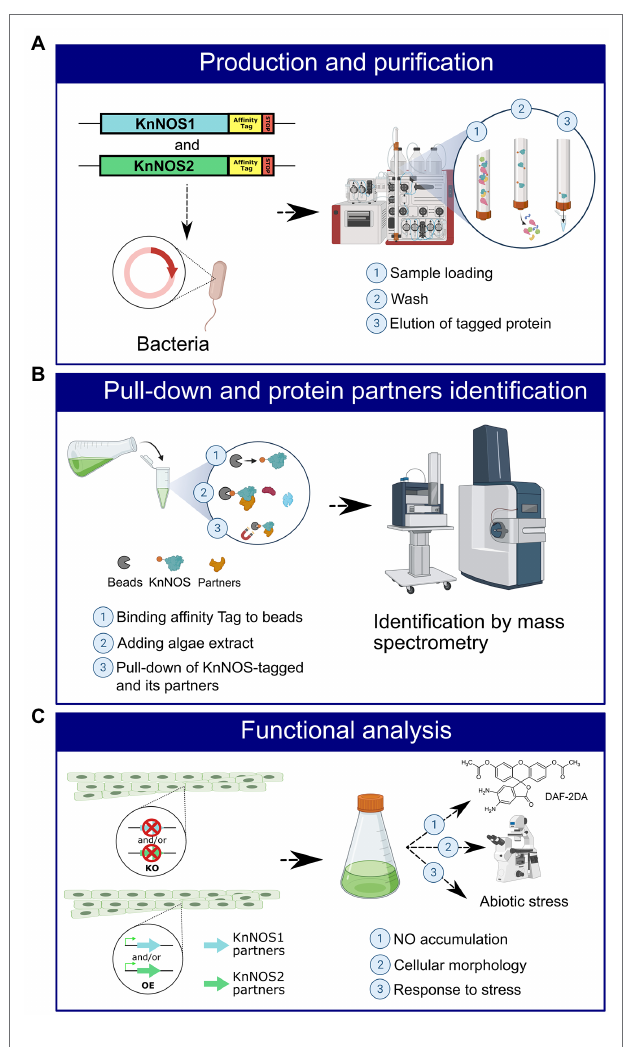
FIGURE 5 | Schematic representation of the strategy for identifying NOSs protein partners and their characterization. (A) An affinity tag will be added by molecular engineering to the sequence coding for KnNOS1 and KnNOS2. The two inserts will be cloned in vector, and the two recombinant proteins will be produced in heterologous system. Recombinant proteins KnNOS1 and KnNOS2 will be purified by affinity chromatography. (B) Purified KnNOS1 and KnNOS2 will be coated on magnetic beads. Pull-down assay will be carried out to precipitate KnNOSs and their respective partner proteins. Partner proteins will be identified by mass spectrometry. (C) A functional analysis using targeted genetic approaches will allow the characterization of the physiological functions of KnNOSs through study of their partner